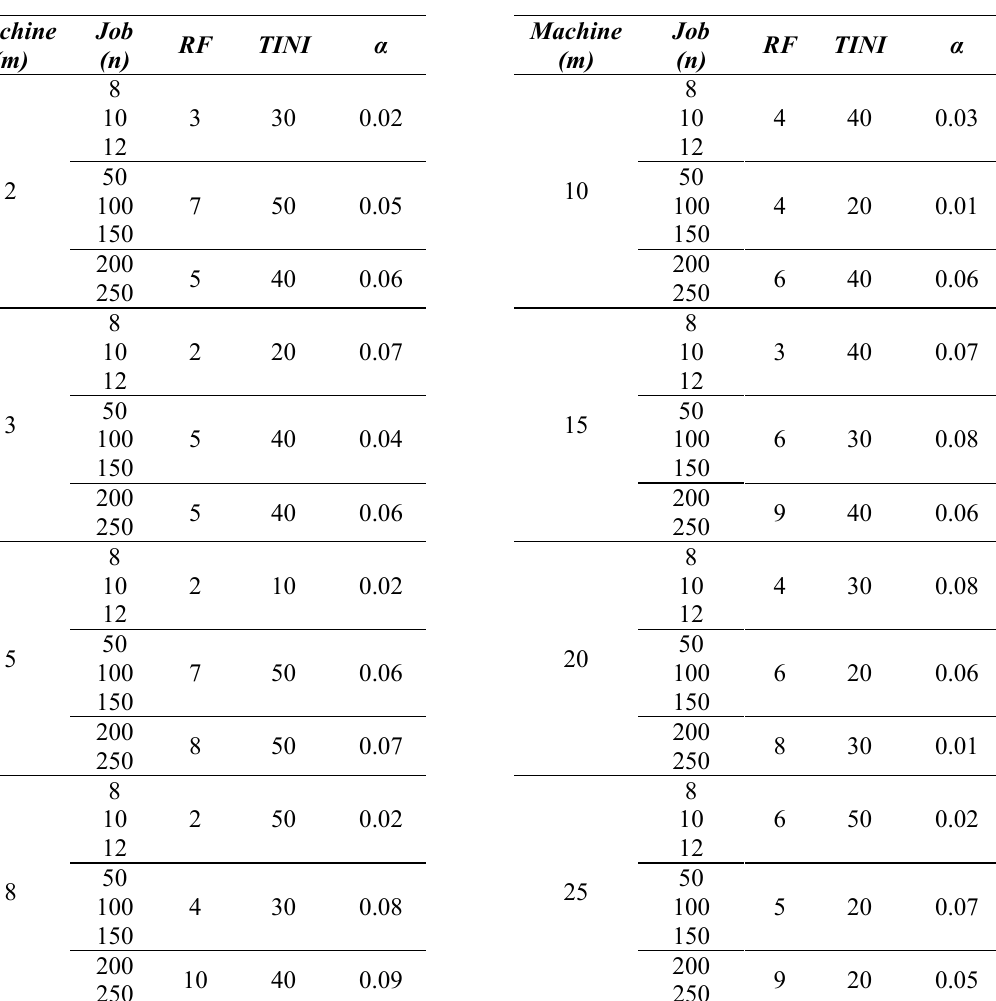
Table 3. Best parameter